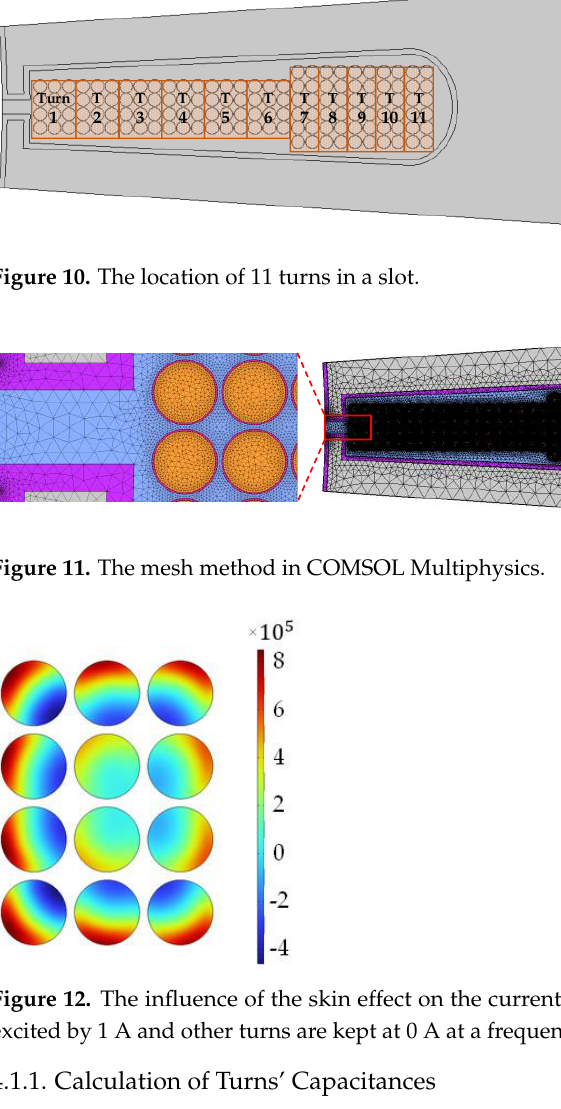
Figure 12. The influence of the skin effect on the current density of turn 1 (A/m 2 ) when turn 1 is excited by 1 A and other turns are kept at 0 A at a frequency of 100 kHz.